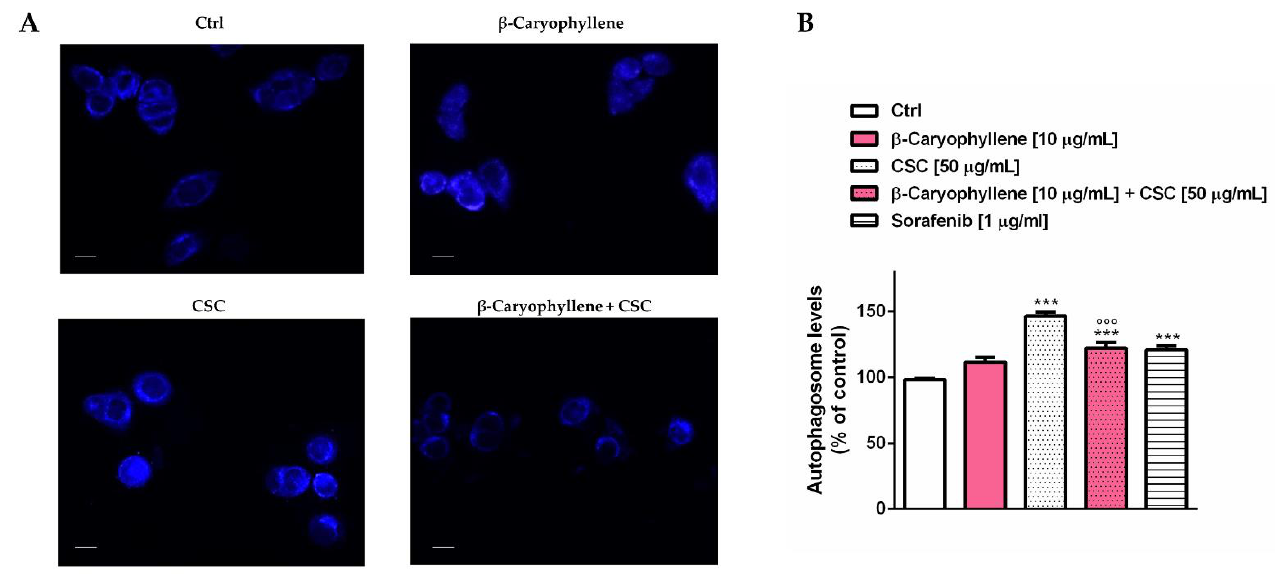
Figure 12. Autophagic cell death induced by β -caryophyllene, cigarette smoke condensate (CSC) and the positive control sorafenib in MDA-MB-468 cancer cells after 24 h exposure. ( A ) Representative images of cells stained by autophagosome detection reagent. ( B ) Bar graphs of fluorescence intensity as determined by quantitative analysis using autophagosome detection reagent. Data are displayed as mean ± SE of at least three independent experiments with at least three technical replicates ( n = 9). *** p < 0.001, significant lowering of cell viability with respect to the control (ANOVA + Dunnett’s multiple comparison post -hoc test). °°° p < 0.001, significant difference with respect to CSC (Student’s t -test). Scale bars = 10 μm.